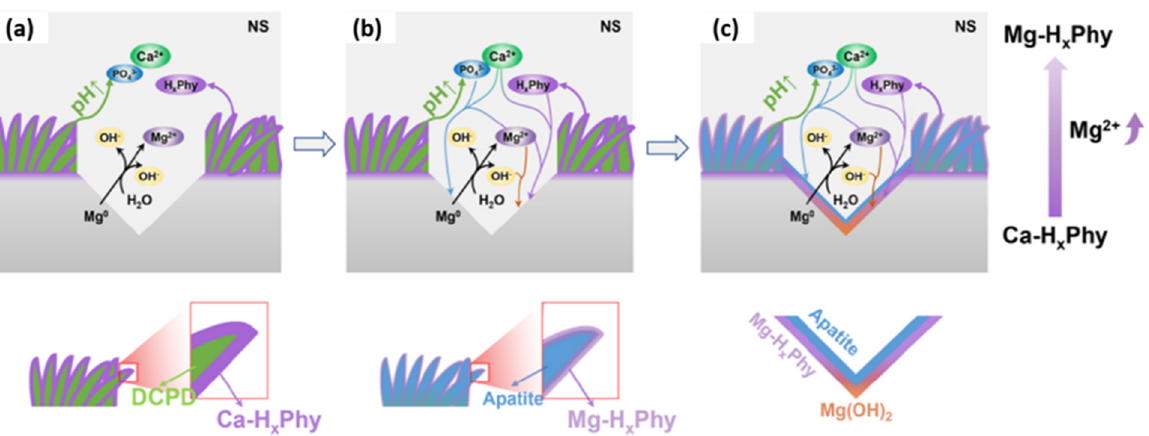
Figure 10. Schematic diagram of self-healing mechanism of the scratched phytate-modified DCPD coatings in 0.9 wt.% NaCl solution (NS) (DCPD: dicalcium phosphate dihydrate coating; Phy: phytate). The self-healing mechanism is in order from ( a – c ). Reprinted from [170] with permission from Elsevier.